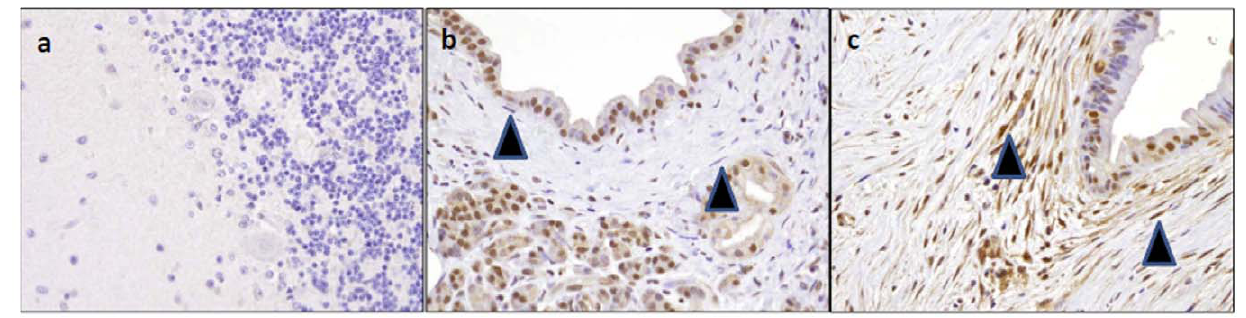
Figure 6. Immunohistochemical analysis of Adam12 protein expression in tissue microarrays. (A) Adam12 protein expression is undetectable in the granule cell layer of the brain (negative control tissue). (B) Stromal fibroblasts (arrows) surrounding normal pancreatic duct do not label Adam12. (C) Cancer associated fibroblasts (arrows) in a primary pancreatic adenocarcinoma are strongly positive for Adam12 protein; magnification, 20 6